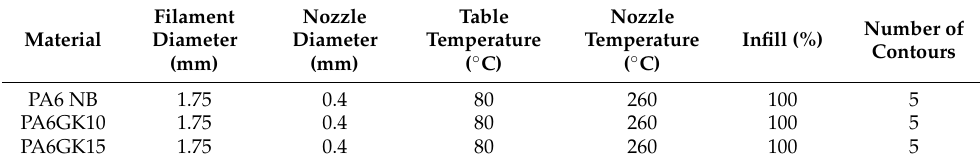
Table 2. Parameters of the FFF process suggested by the filament